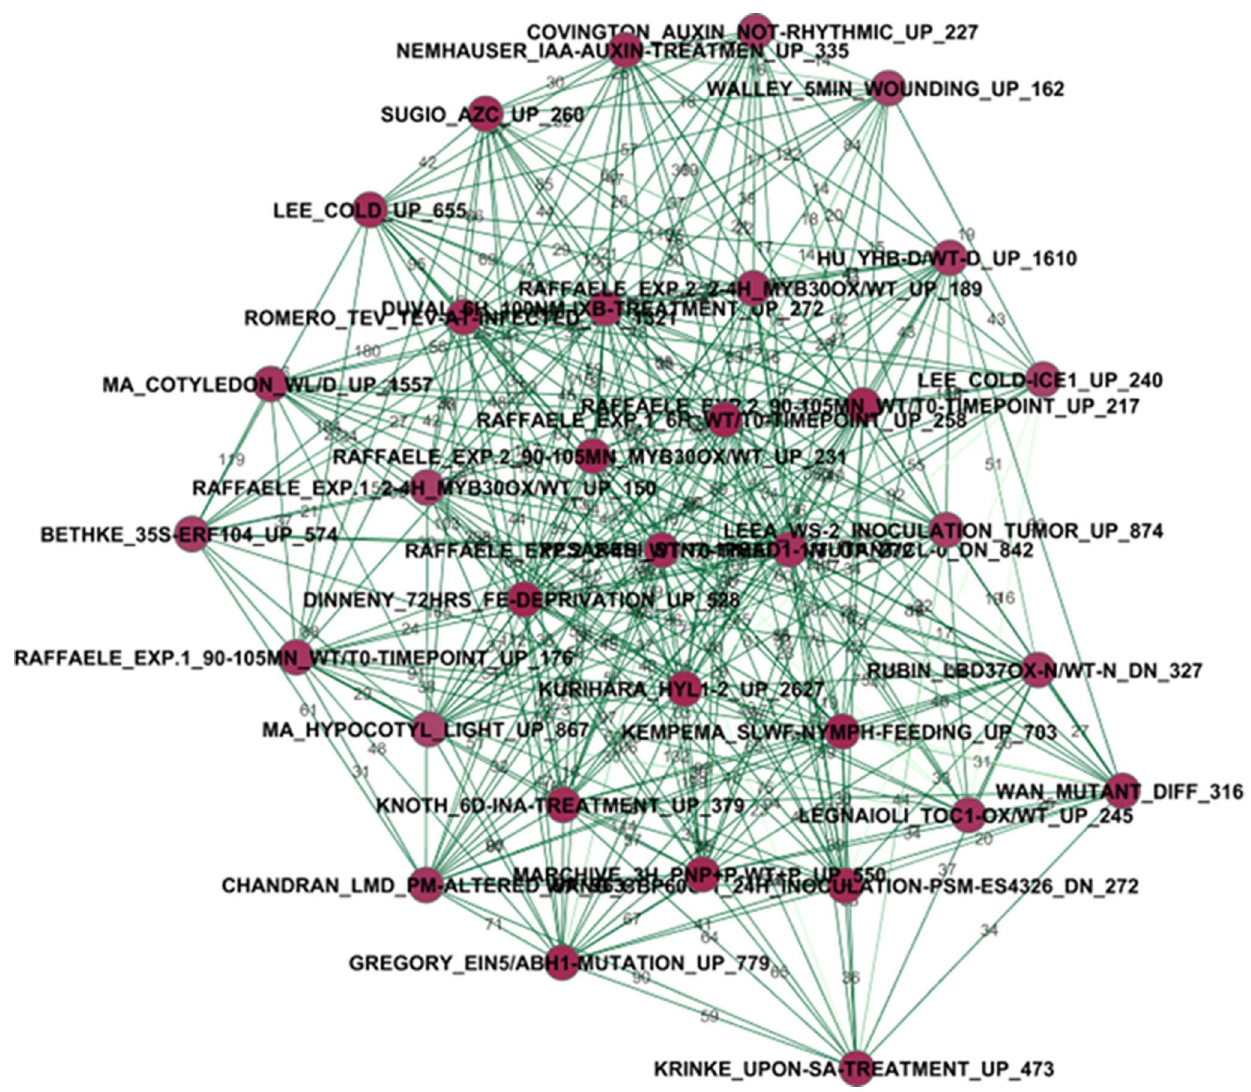
Figure 5. Sub-network 3 corresponding to the module 3/cluster 3 (see note in Figure 2 for meanings of node and edge and their color. edge label = number of overlapping genes between two nodes).